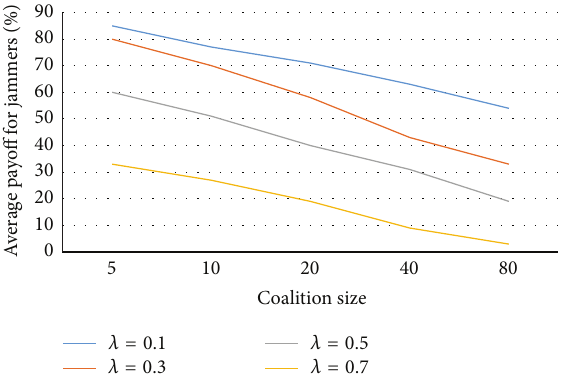
Figure 11: Average payoff of the insider jammer after